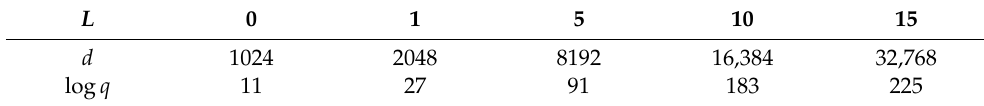
Table 1. Dimensions of degree d and modulus q at the different circuit depths.